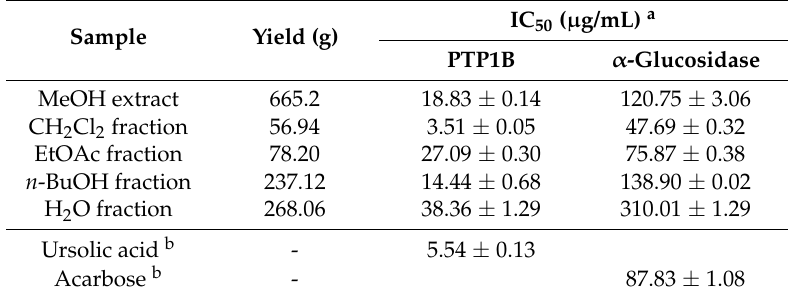
Table 1. Abilities of the MeOH extract of Epimedium koreanum and its fractions to inhibit protein tyrosine phosphatase1B (PTP1B) and α -glucosidase. Sample Yield